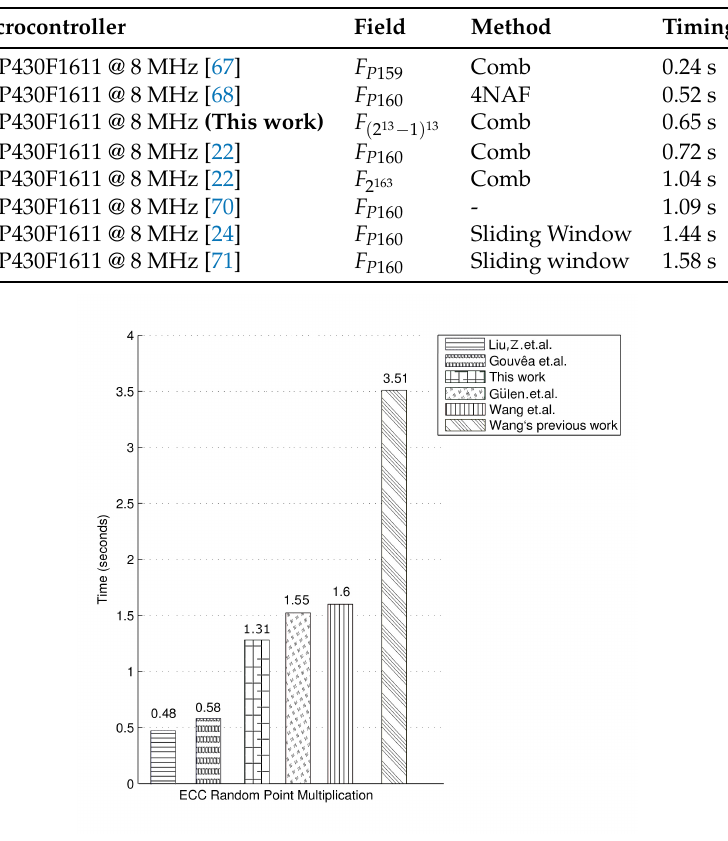
Figure 1. Comparison for random point multiplication timings.